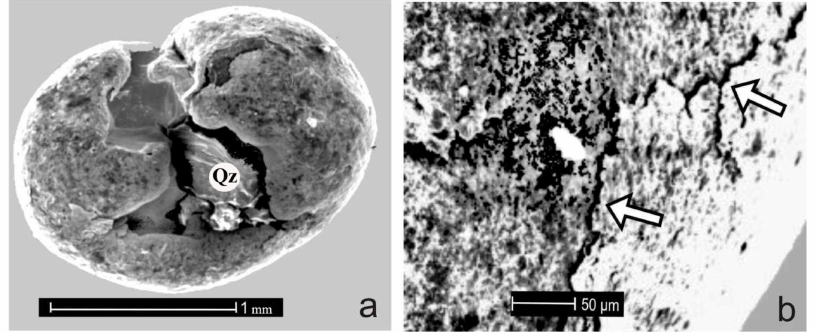
Figure 7. Intergrowth of native gold and quartz (quartz relics in the depth of the cavity, transformed into a lumpy-spherical shape in an experimental facility): ( a ) general view; ( b ) detail, the filmy-fibrous surface of gold (shown by arrows); Qz =